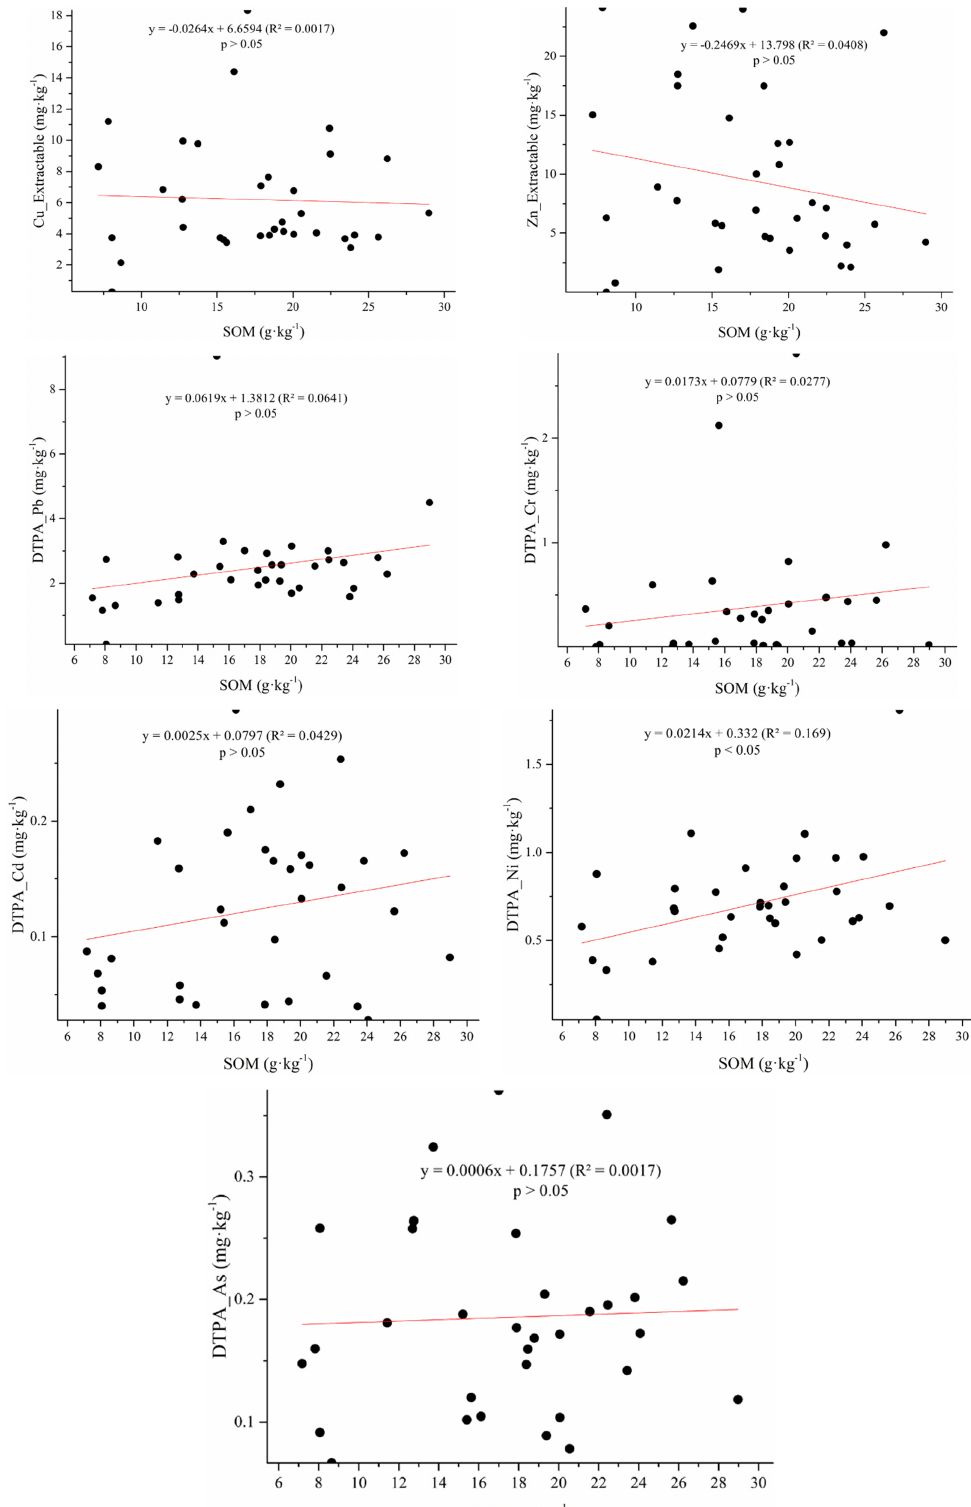
Figure 5. DTPA-extractable metal content (mg·kg − 1 ) versus soil organic matter content (g·kg − 1 ).